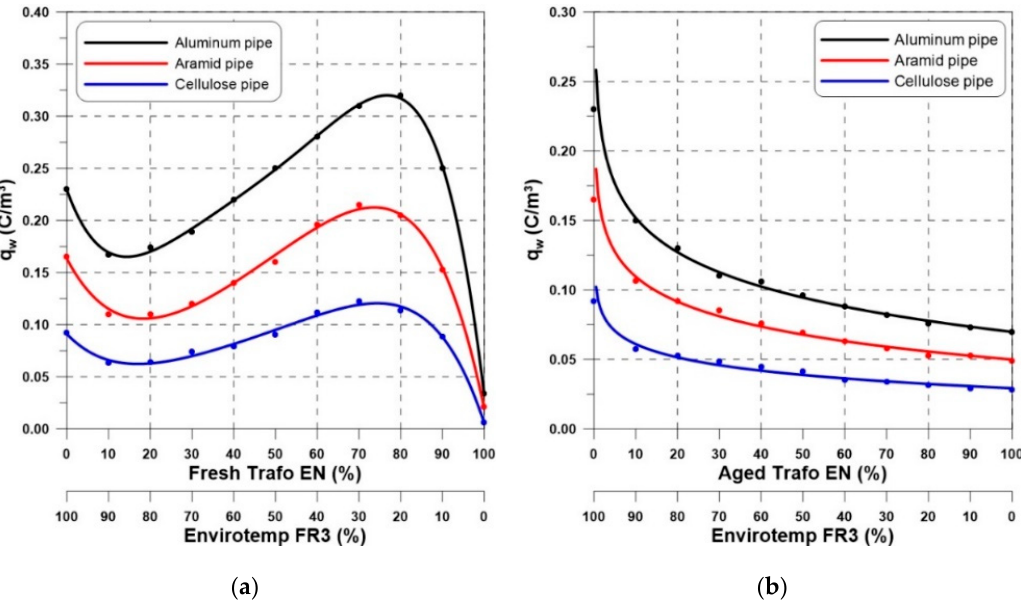
Figure 6. Volume charge density q w vs. mixing of Envirotem FR3 natural ester with ( a ) fresh and ( b ) aged Trafo EN mineral oil.